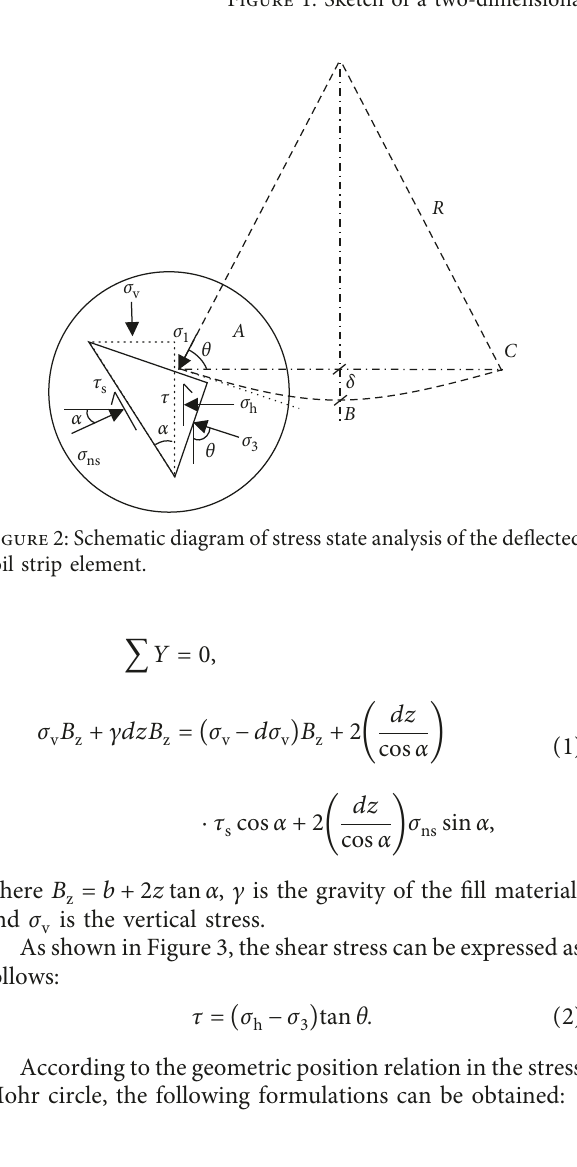
Figure 1: Sketch of a two-dimensional embankment section after local subsiding.